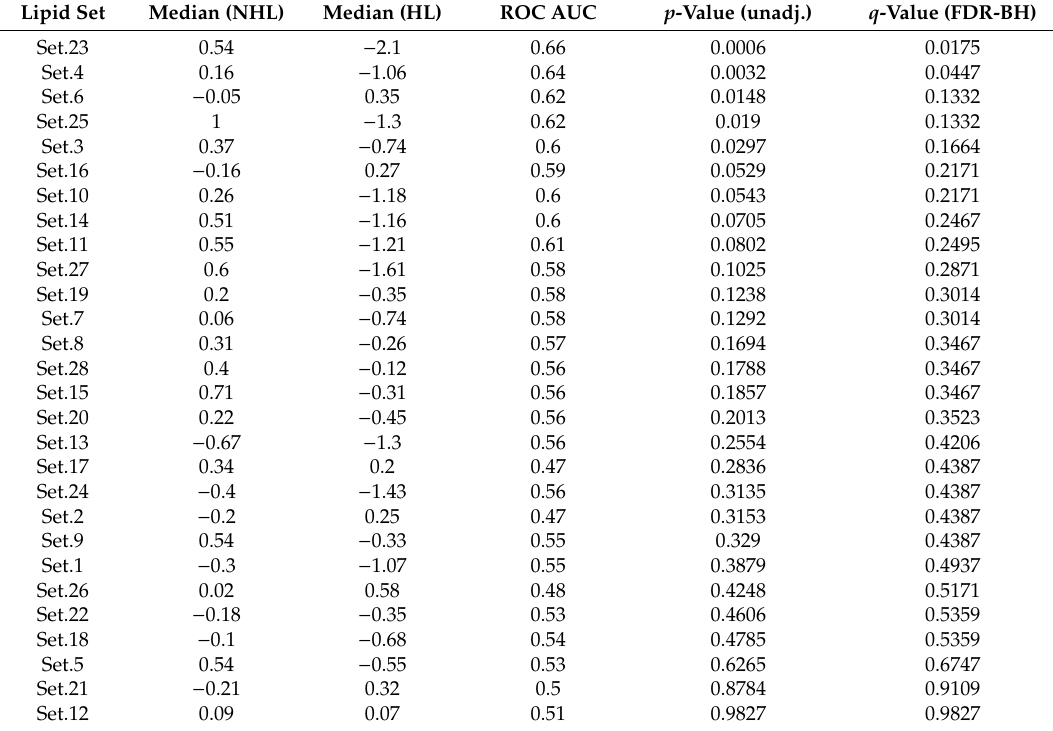
Table 3. Table of lipid sets derived from Barupal et al. (2019) and their performance in distinguishing HL from NHL in Alzheimer’s disease (AD) subjects. ROC AUC = receiver operating characteristic area under the curve. FDR-BH = Benjamini-Hochberg False Discovery Rate Lipid Set Median (NHL) Median (HL) ROC AUC p -Value (unadj.) q -Value (FDR-BH) Set.23